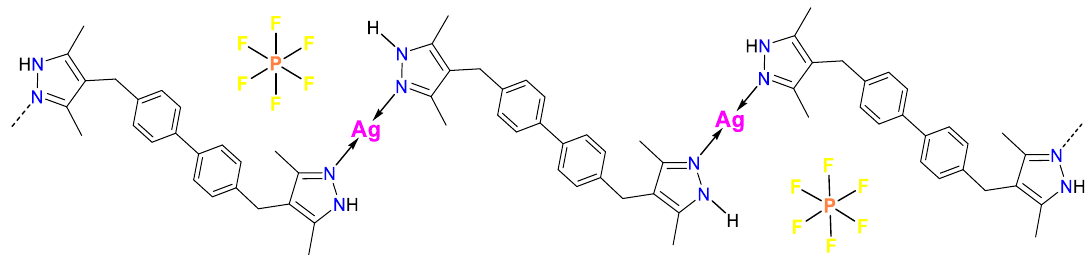
Figure 9. Proposed polymeric structure of [Ag(H 2 DMPMB)(PF 6 )] ( 6 ), evidencing the digonal stereochemistry of silver(I) ions assured by the neutral ligands coordinated in a bridging exo-bidentate mode.